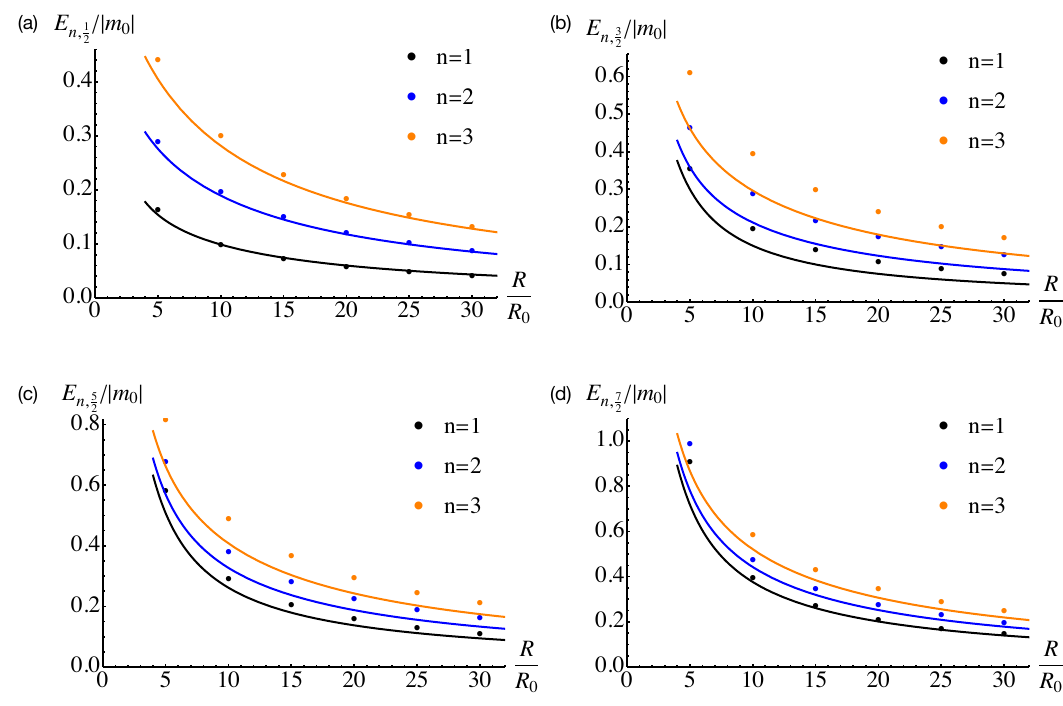
| of the surface states for a nanocylinder Figure 1: The quantised energy in units of | m 0 of height L = 10 R as a function of the radius R , for different values of the quantum 0 number n and j = 1 / 2 panel (a), j = 3 / 2 panel (b), j = 5 / 2 panel (c), and j = 7 / 2 panel (d). The filled circles correspond to the results of the numerical calculation = 0.25 R = 0.05 R with discretisation constants a and a , while the solid lines are r z 0 0 obtained with the analytical